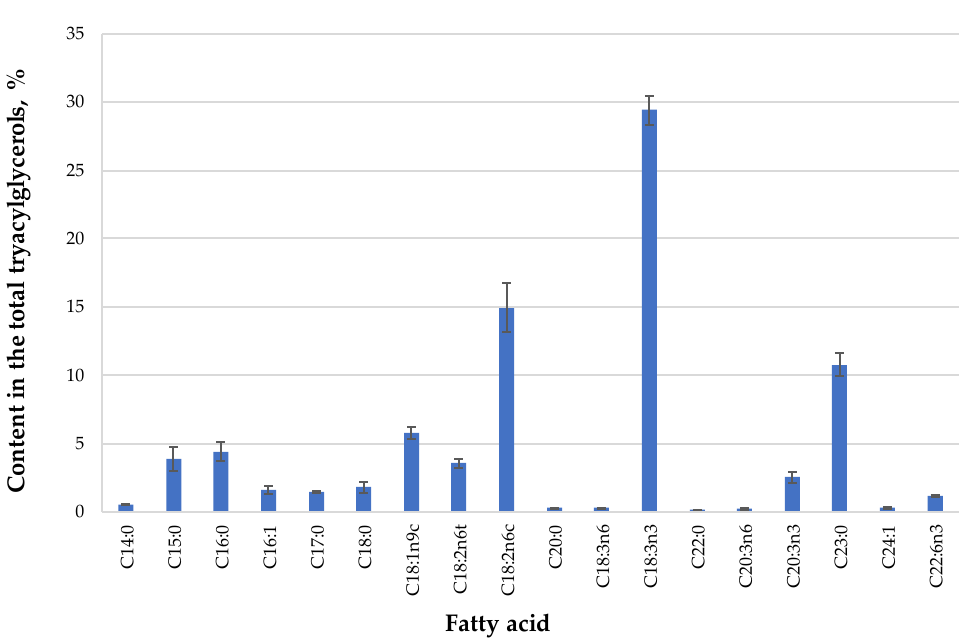
Table 1. Yields (g/100 g), total phenolic content (TPC, mg GAE/g), ABTS •+ , and DPPH • scavenging capacity (TEAC, mg TE/g) of D. fruticosa leaves solid residues after SFE-CO 2 and Soxhlet extractions.